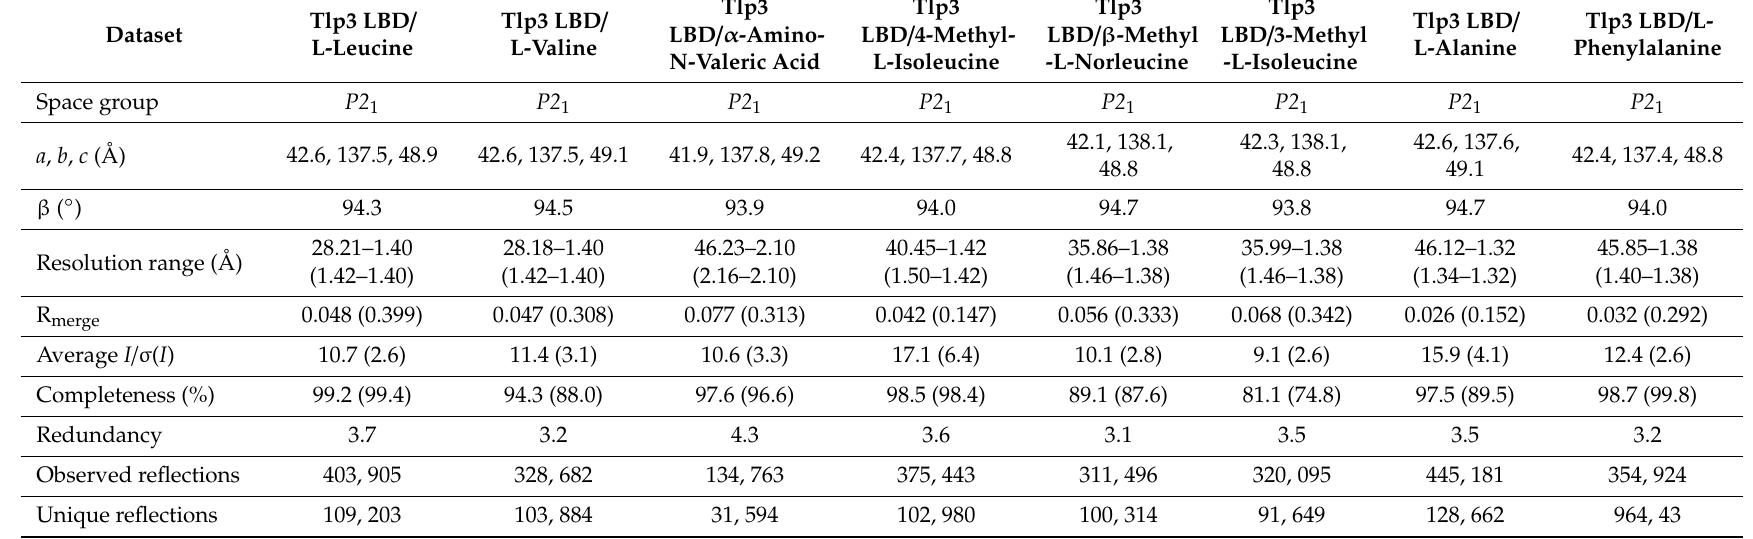
Table 2. X-ray data processing statistics. Values in parentheses are for the highest resolution